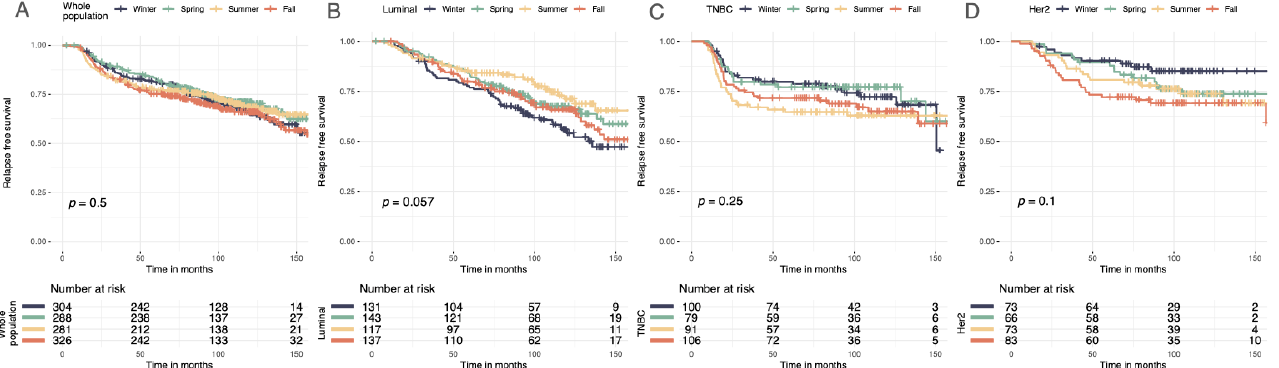
Figure 5. Relapse-free and overall Kaplan – Meier survival curves by season at BC diagnosis. ( A ) Relapse-free survival curves according to season. ( B ) Relapse-free survival curves in luminal breast cancer according to season. ( C ) Relapse-free survival curves in TNBC breast cancer according to season. ( D ) Relapse-free survival curves in Her2 -positive breast cancer according to season. ( E ) Overall survival curves according to season. ( F ) Overall survival curves in luminal breast cancer according to season. ( G ) Overall survival curves in TNBC breast cancer according to season. ( H ) Overall survival curves in Her2 -positive breast cancer according to season. 4. Discussion In this study analyzing immune infiltration, response to treatment, and oncologic outcomes according to the seasonality of BC diagnosis in a cohort of patients treated with NAC, we found little, if any, association between seasonality and the parameters we ana- lyzed. Our study adds insights to the existing evidence, summarized in Table S3. First , in our cohort, the season of diagnosis was evenly distributed throughout the year. In contrast, out of 2,921,714 BC cases diagnosed worldwide, Oh and colleagues [58] found that BC was consistently diagnosed more often in spring and fall, and irrespective of menopausal status. Among 2895 patients who self-detected an incident BC, Ross et al. [59] found that the monthly peaks in detection occurred in spring and late fall, though these seasonal variations were significant only for ER-negative tumors but not for ER- positive ones. The Swedish cancer register also identified a clear decrease in the frequency of new cases diagnosed during the summer months, followed by a transient increase in subsequent months [47]. Seasonal variations with winter peaks were also evidenced in Korea [46]. The authors concluded that accessibility to healthcare services and logistics for screening programs are two of the most significant factors affecting the seasonality of can- cer detection. The lack of an association between season of diagnosis and incidence in our study could be explained by the characteristics of the population, consisting of patients with large tumors treated with NAC, which are classically not diagnosed within screening programs but are rather interval-diagnosed tumors [60].